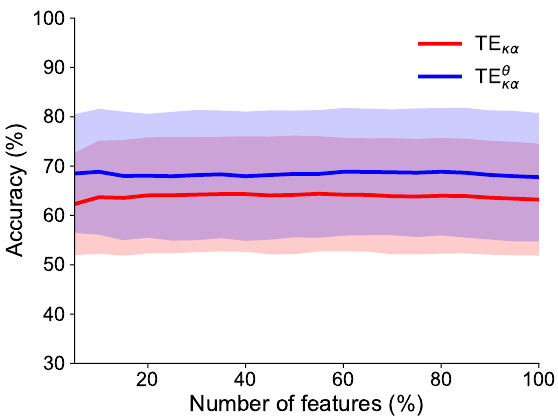
Figure 6. Average classification accuracies, and their standard deviations, for all subjects in the MI database as a function of the number features selected to train the